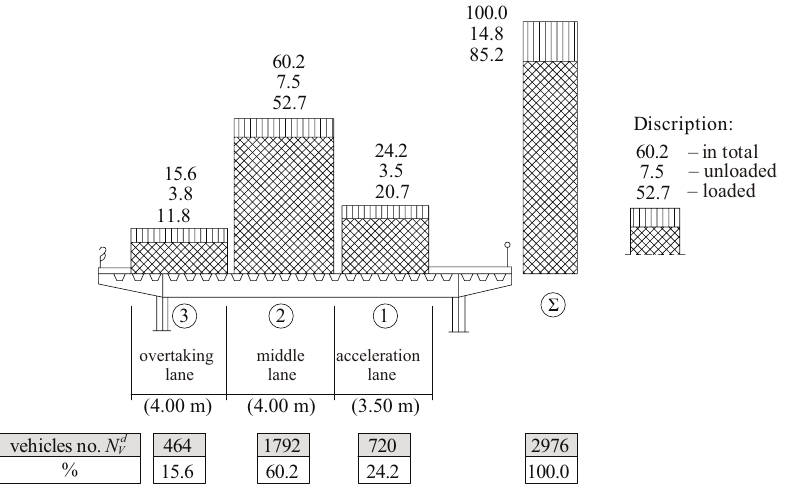
Figure 3. Frequencies of occurrence of heavy goods vehicles in percent on individual traffic lanes of a six-lane